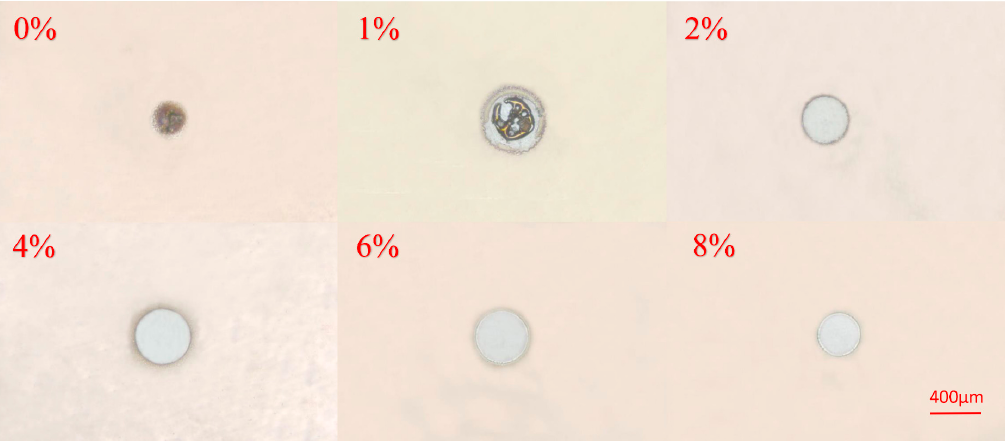
Figure 7. Optical microscopy images of photoresist etched by plasma microjets with different additive oxygen ratio from of 0, 1, 2, 4, 6, and 8%, the diameters from 2 to 8% were 322, 438, 429, and 310 µ m, respectively. Other etch parameters were: applied voltage 8.5 kV pp with a frequency of 11 kHz, helium flow rate fixed at 700 sccm, etch time of 3 min and a distance of 1 mm.